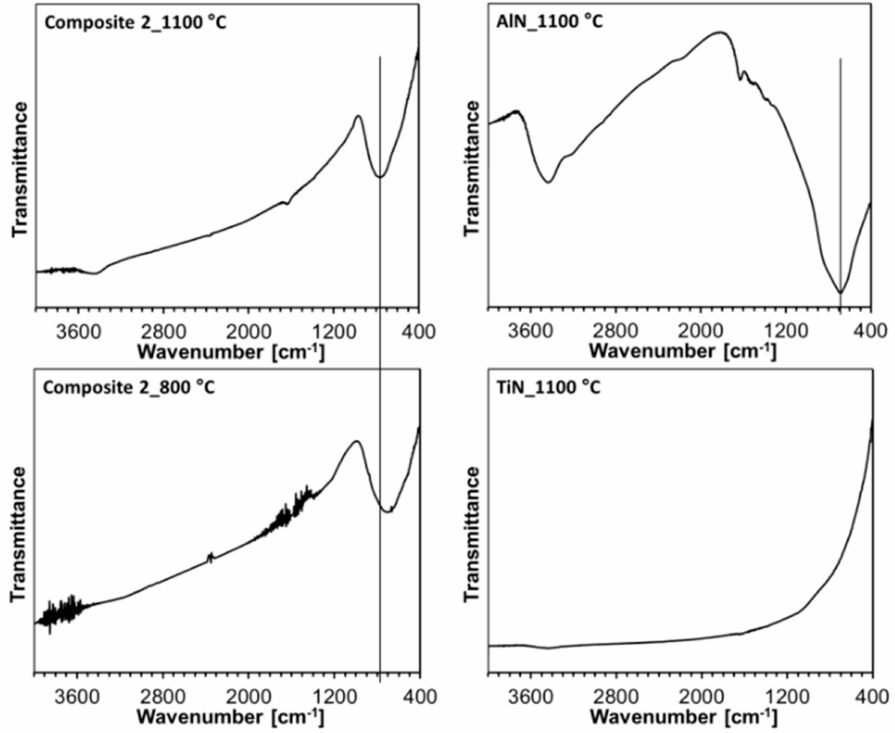
Figure 4. FT-IR spectra of Composite 2 nanopowders from nitridation at 800 and 1100 ◦ C ( left panel ) and individual AlN and TiN nanopowders from nitridation at 1100 ◦ C ( right panel ). Note, non-specific features often include water vapor H 2 O and CO 2 subtraction bands (noise-like) as well as liquid H 2 O bands (broad features) at ca. 3430 cm − 1 (stretching mode) and 1640 cm − 1 (bending mode) for adsorbed water. Solid lines in the range of Al-N stretching vibrations are guides for the eye